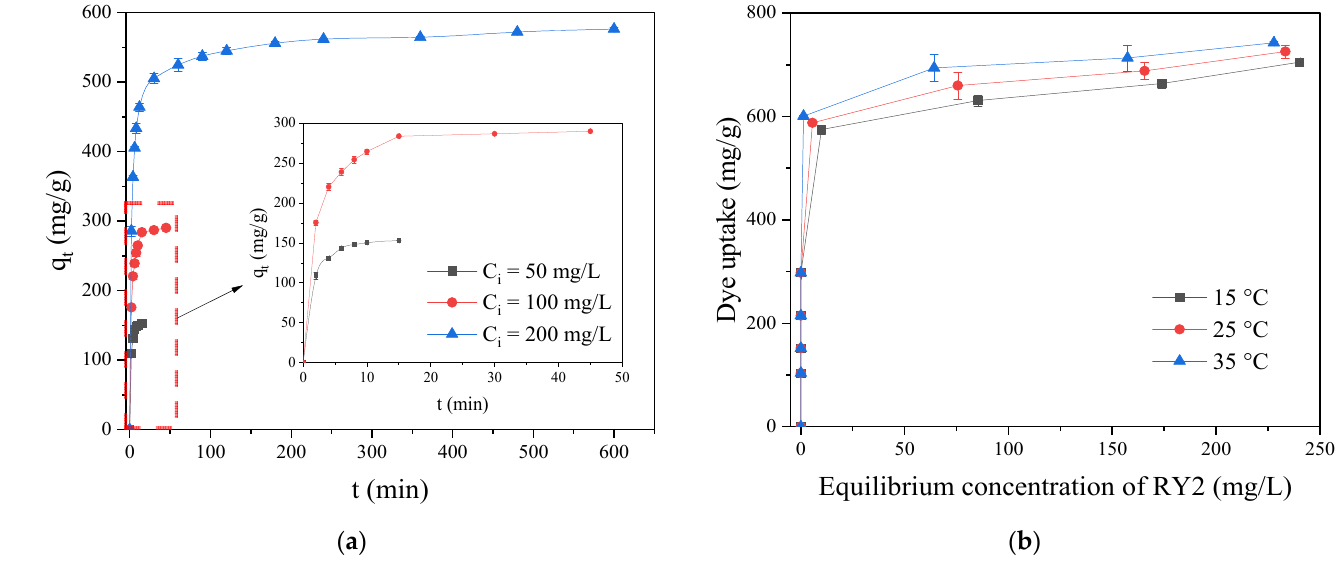
Figure 6. ( a ) Adsorption kinetics of RY2 on PEI/APTES-MWCNTs at 50 ‒ 200 mg/L initial concentra- tions; ( b ) adsorption isotherm of RY2 on PEI/APTES-MWCNTs at different temperatures (15 ‒ 35 °C).